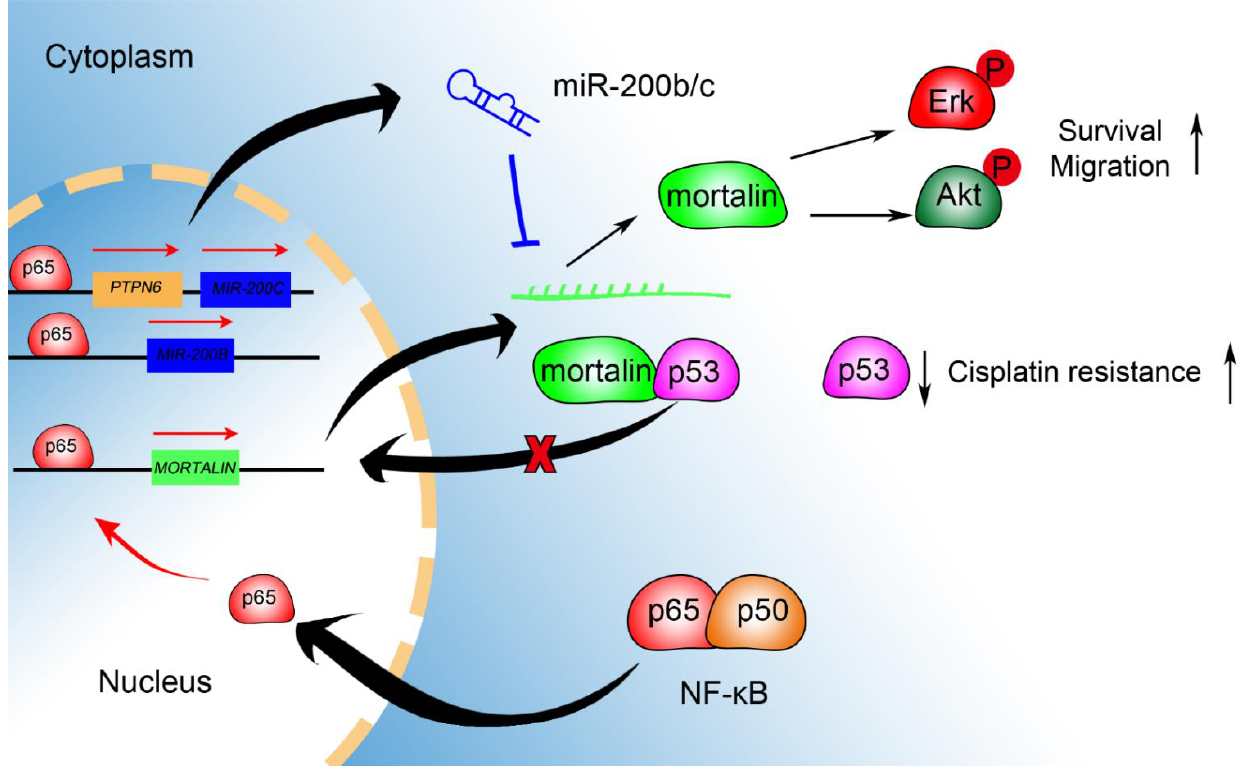
Figure 7. Summary model. Schematic representation of the regulation of mortalin expression and its downstream bi0logical effects.